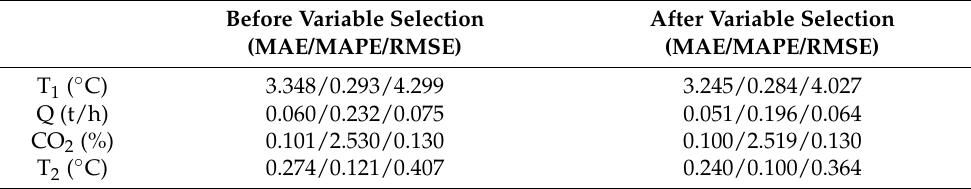
Table 3. Evaluation index of the influence of variable selection on modeling results.